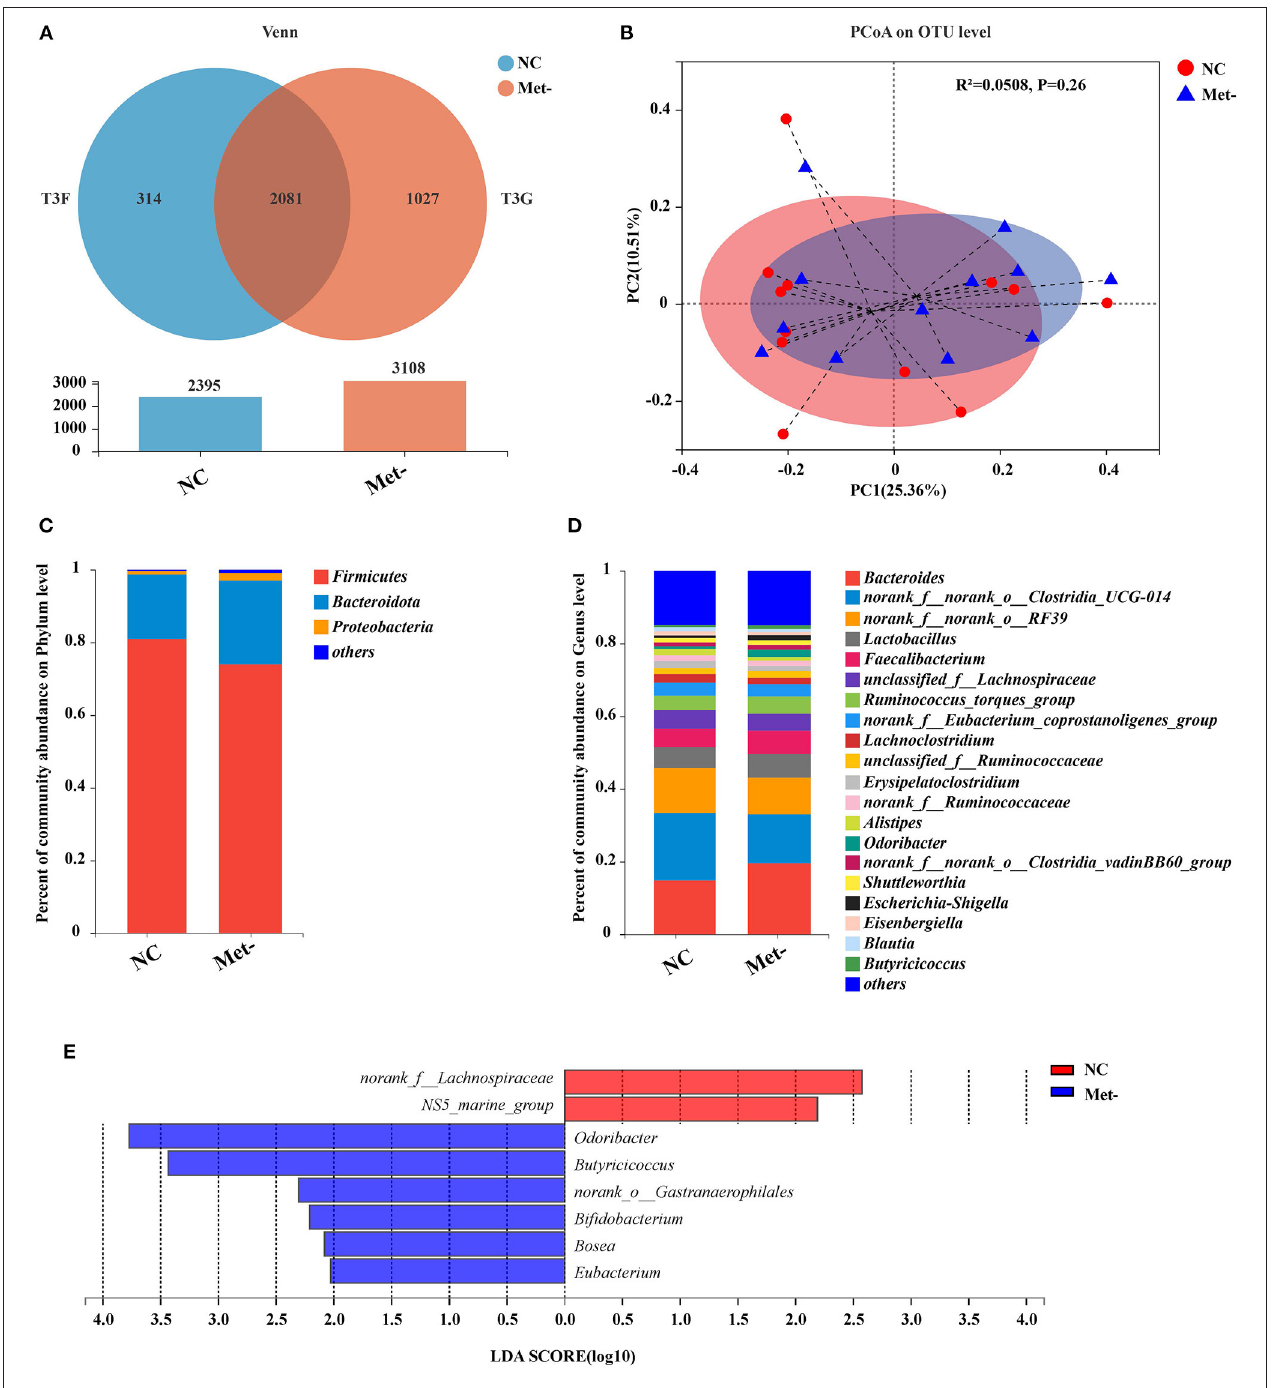
FIGURE 3 | Effects of Met deficiency in rearing period diets on the gut microbiota of egg-laying chicks at 6 weeks. (A) Venn diagram of the shared and total operational taxonomic units (OTUs) in the NC and Met- groups. (B) The principal coordinate analysis (PCoA) (Bray-Curtis distance) plot of the gut microbial community structure between the NC and Met- group. (C) Relative abundance of gut microbiota at the phylum level. (D) Relative abundance of gut microbiota at the genus level. (E) Histograms of the linear discriminate analysis (LDA) score (threshold ≥ 2) in Met- and NC groups are plotted. Linear discriminate analysis effect size (LEfSe) was performed to determine the difference in